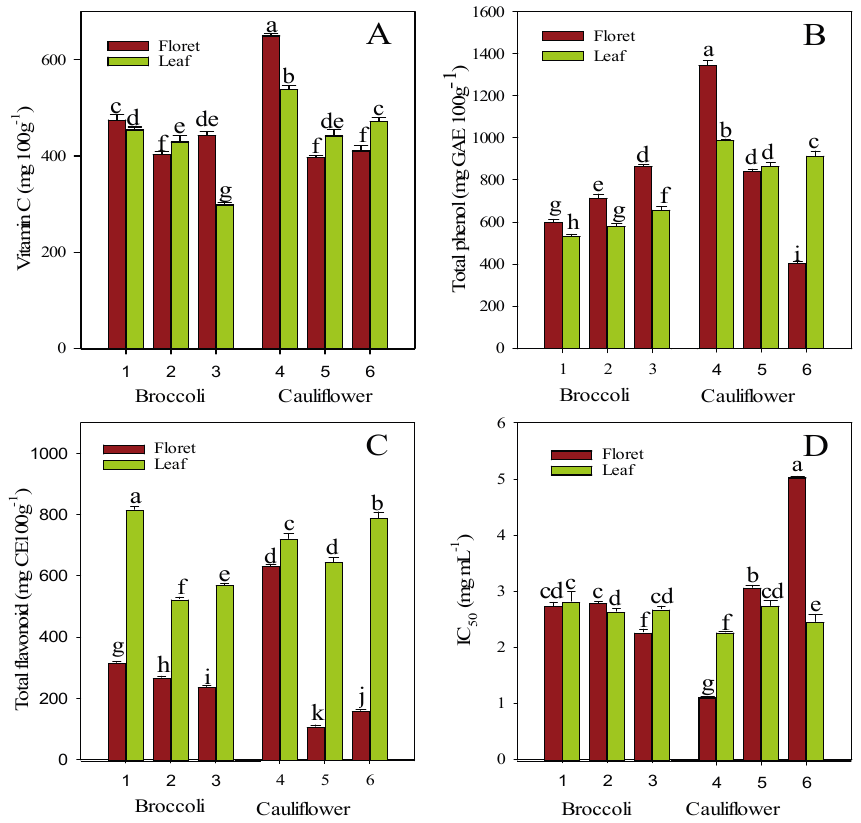
Figure 1. Vitamin C ( A ); total phenol ( B ); total flavonoid ( C ); and antioxidant activity ( D ) in floret and leaf of broccoli and cauliflower cultivars. Each vertical bar represents mean ± SD of three independent replications; different letters within a box indicate a statistically significant difference at p < 0.05 by Duncan’s multiple-range test. Broccoli cultivars: 1, AMaGi; 2, Baeridom; 3, Cheonjae. Cauliflower cultivars: 4, Asia purple; 5, Asia white; 6,